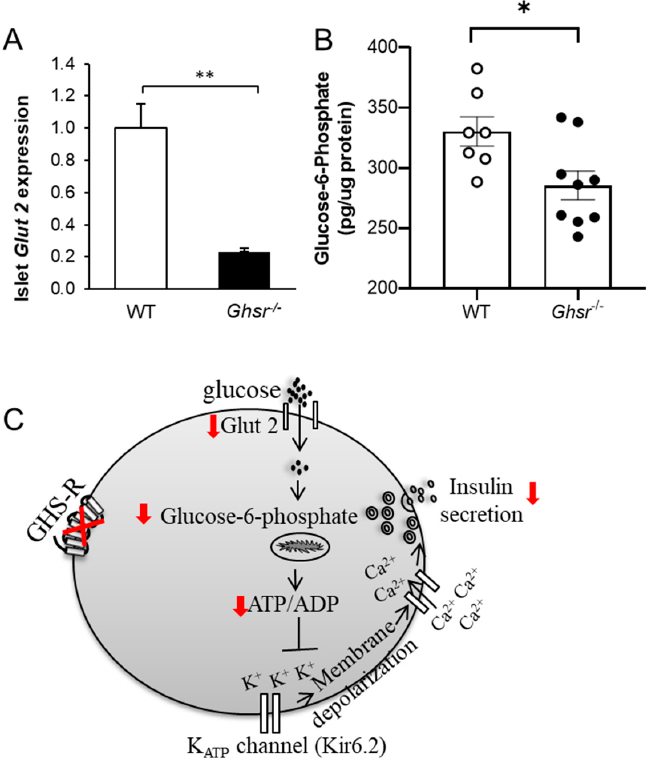
Figure 3. Glucose uptake is reduced in Ghsr − / − mice. ( A ) Glut2 gene expression was measured in islets of 6.5-month-old WT and Ghsr − / − mice, n = 5. ( B ) G6P was measured from the pancreas of 4-month-old WT and Ghsr − / − mice, which were fasted overnight, injected with glucose and then sacrificed 60 min later, n = 7–9. ( C ) Schematic diagram of impairments in GSIS pathway in Ghsr -ablated β -cells. Impaired Glut2 expression leads to the reduced formation of G6P, contributing to the lower generation of ATP, resulting in attenuated insulin secretion. * p < 0.05, ** p < 0.001, WT vs. Ghsr − / − .